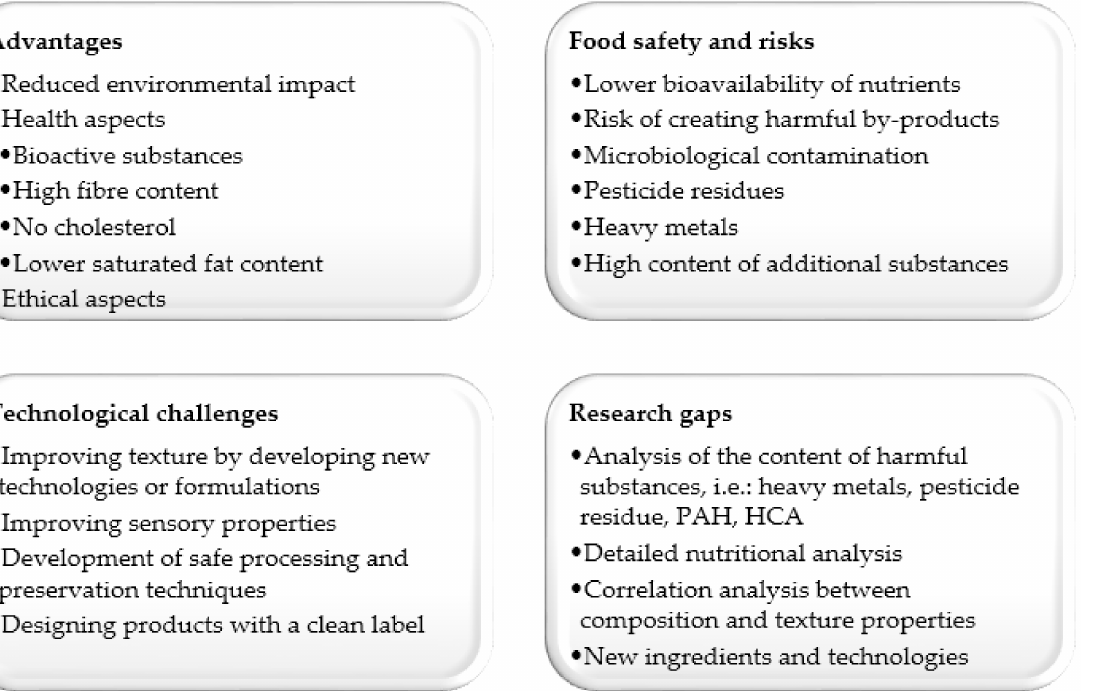
Figure 2. Advantages, risks, technological challenges, and research gaps associated with meat analogues (PAH- polycyclic aromatic hydrocarbons; HCA- heterocyclic aromatic